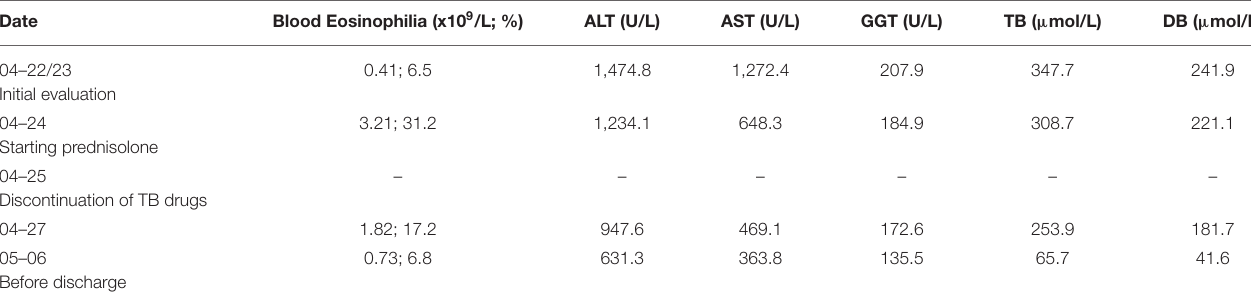
TABLE 1 | Laboratory values in the course of the